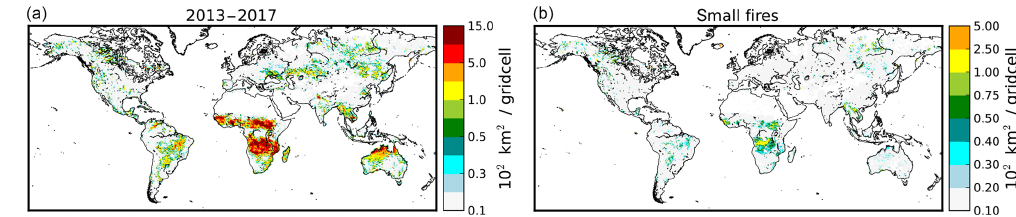
Figure 2. Average yearly burned area during the period 2013–2017 within 0.5 ◦ × 0.5 ◦ grid cells as derived from the MODIS burned area product MCD64 (a) and including small fire contributions from MODIS active fire detection (MOD14) only (b)